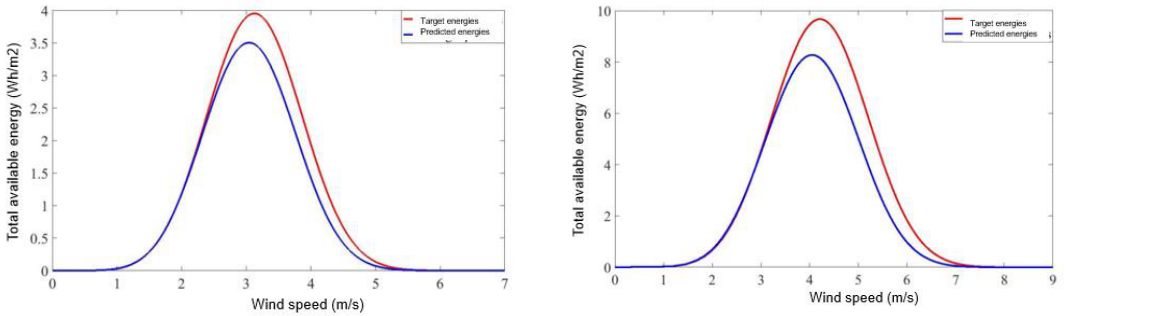
Figure 5. Target and predicted energy curves at 10m Figure 6. Target and predicted energy curves at 25m